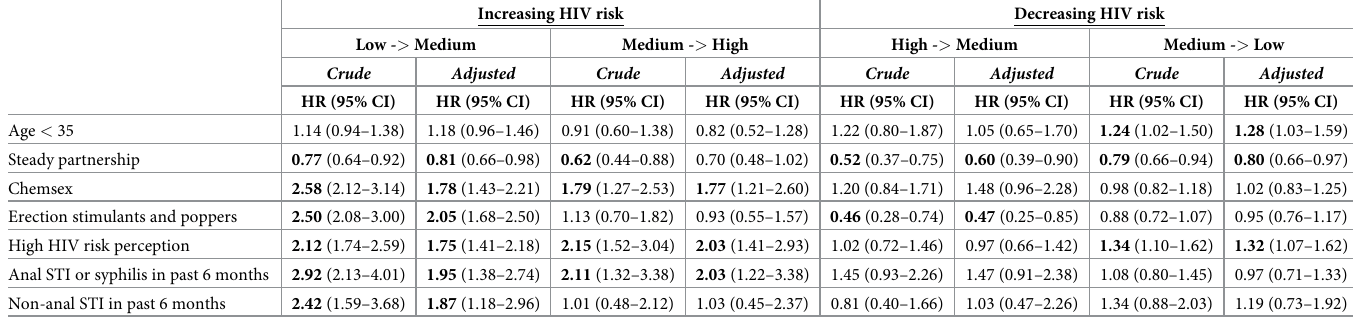
Table 2. Univariable and multivariable determinants of increasing (low to medium, or medium to high risk level) or decreasing HIV risk (high to medium, or medium to low risk level) in proportional hazards analysis among MSM participating in the Amsterdam Cohort Studies, Amsterdam the Netherlands, between 2008 and 2017 (n = 7,427